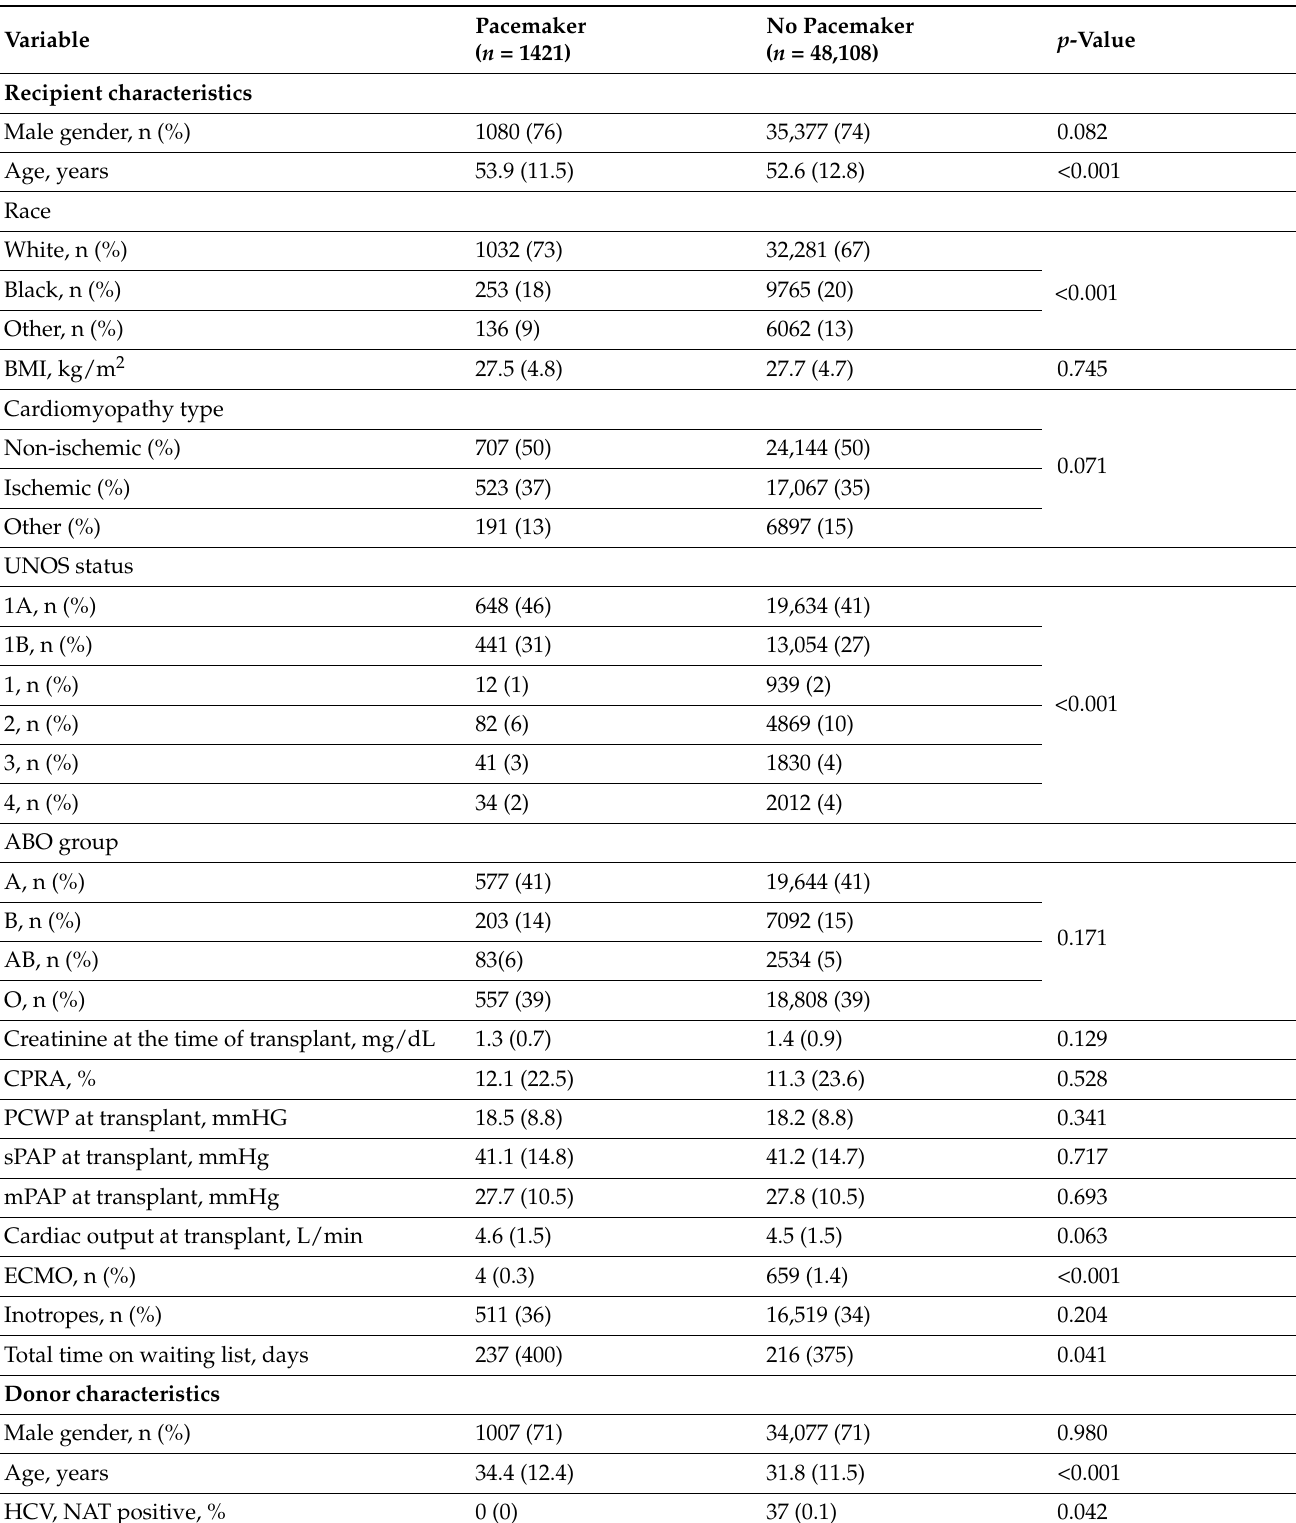
Table 1. Patient demographics, clinical characteristics of donor and recipient populations according to the need for pacemaker implantation post heart